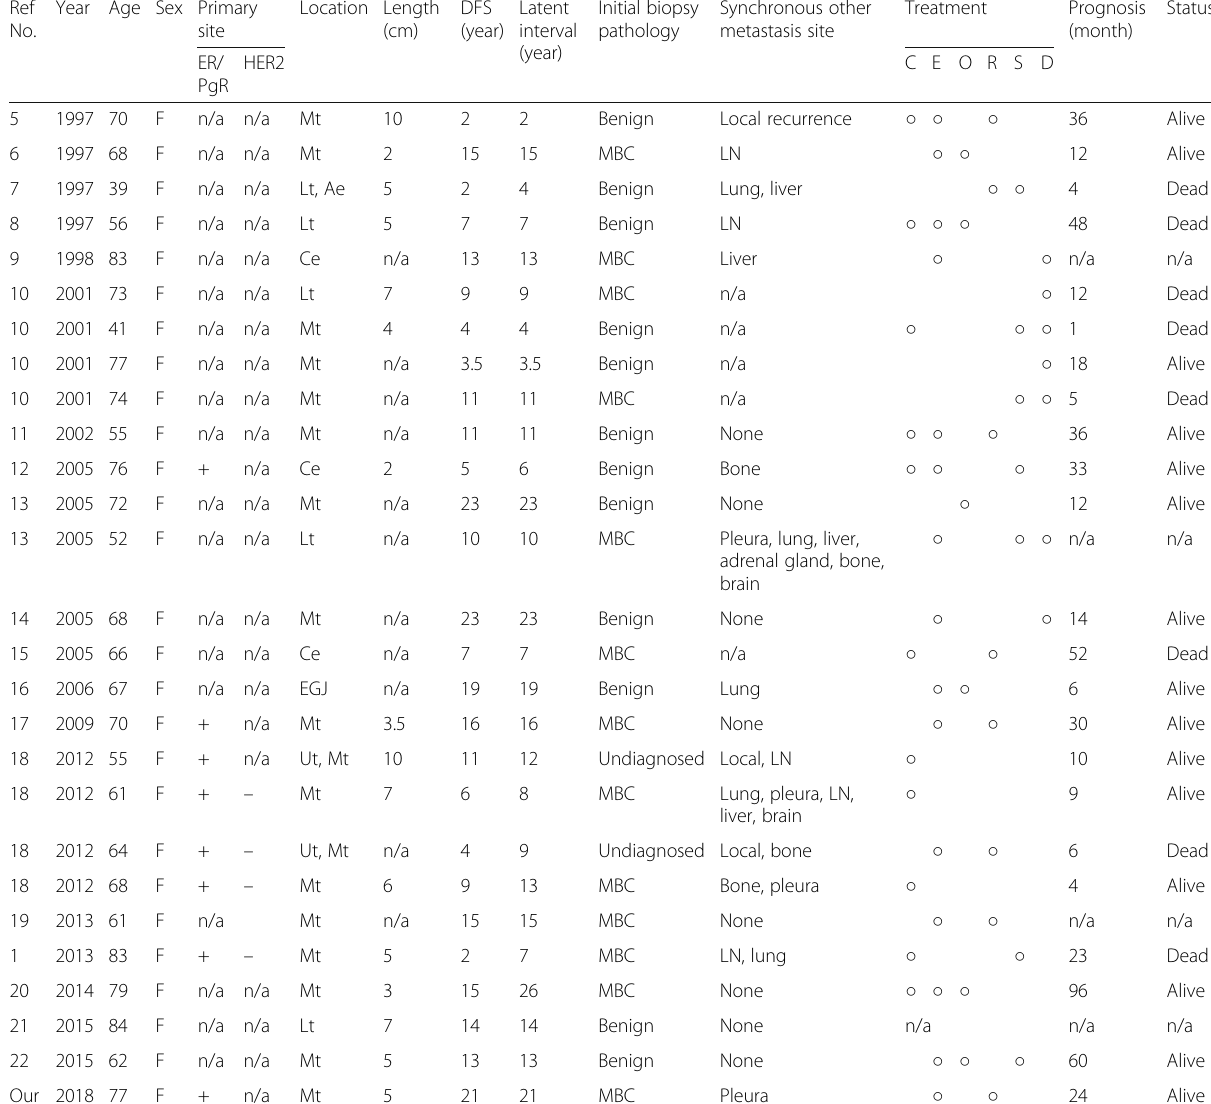
Table 1 Esophageal metastasis from breast cancer for the past 20 years Ref Year Age Sex Primary No.